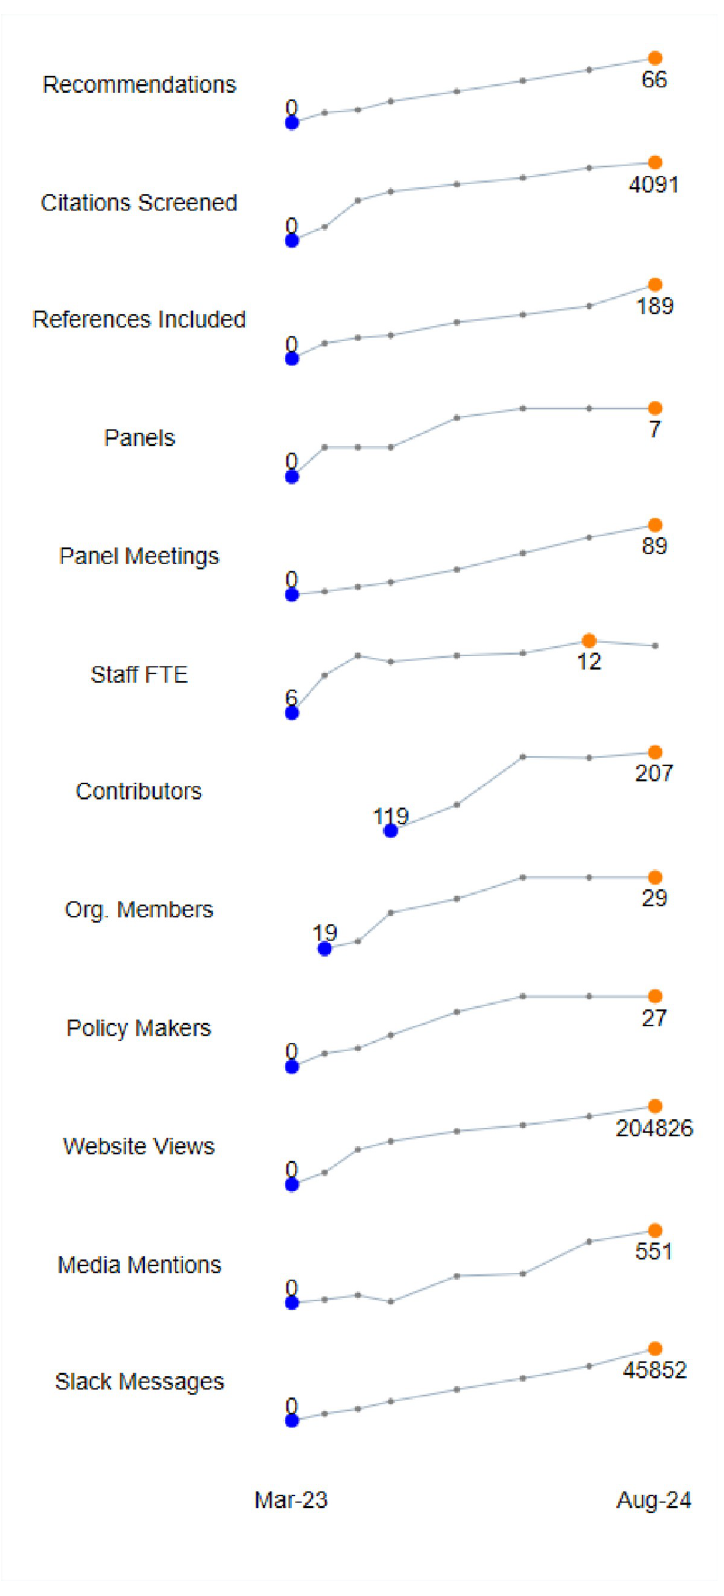
Fig 1. Activity audit